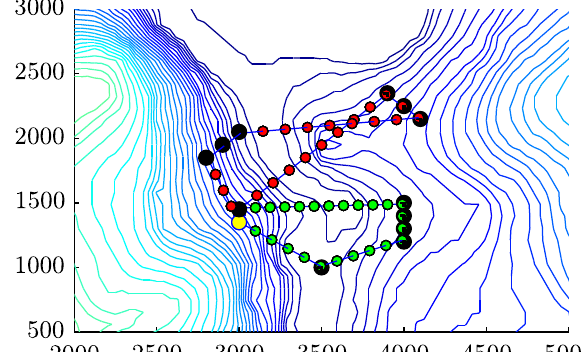
Figure 7: Scenario 0: Top view of the planned path. The black circles represent the waypoints, and the yellow circle is the initial location of the UAVs where also the base station is lo- cated. The red circles represent UAV 1, and the green circles represent UAV 2. The con- tours in the background represent the height of the terrain.